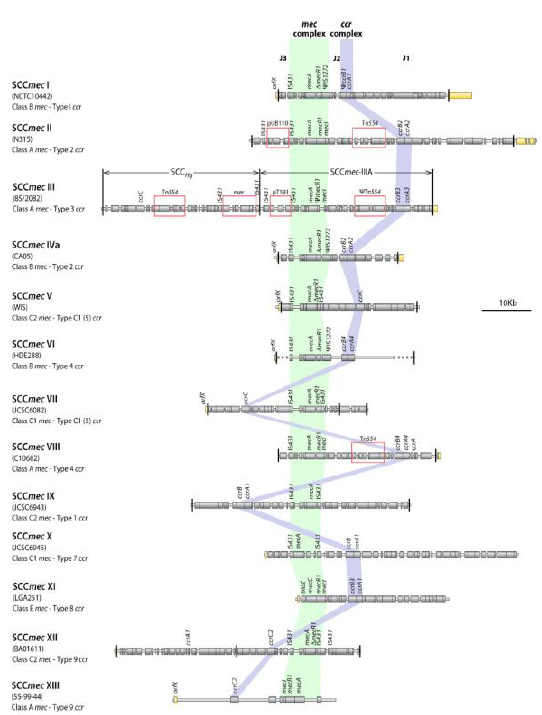
Figure 1. Different SCC mec types